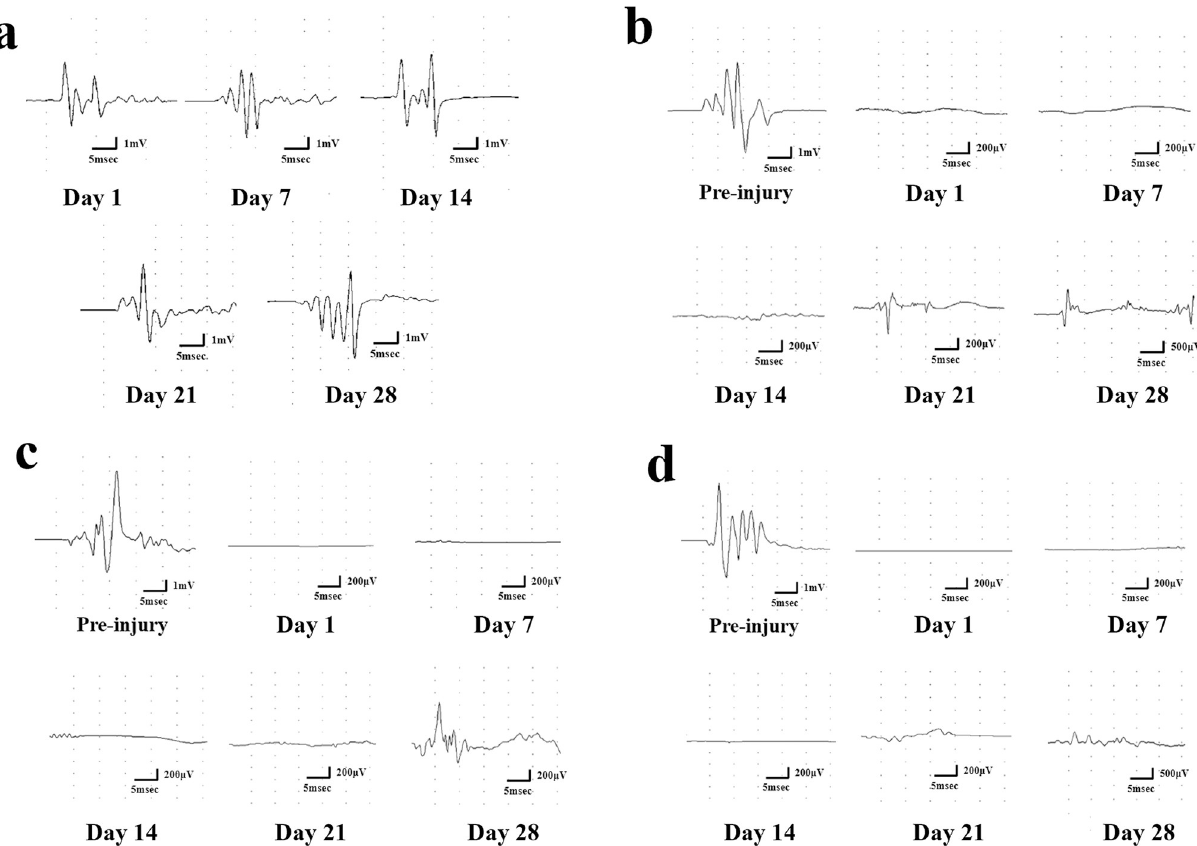
Fig 3. Representative waveforms of transcranial electrically stimulated motor-evoked potentials (tcMEPs). a. Representative waveforms of tcMEPs in control rats on days 1, 7, 14, 21, and 28. b, c, d. Representative reappearing waveform of tcMEPs in spinal cord injury (SCI) rats at preinjury, and on days 1, 7, 14, 21, and 28 in the phosphate buffered saline (PBS), rat bone marrow-derived mesenchymal stem cell (rbMSC), and rat cranial bone-derived mesenchymal stem cell (rcMSC)